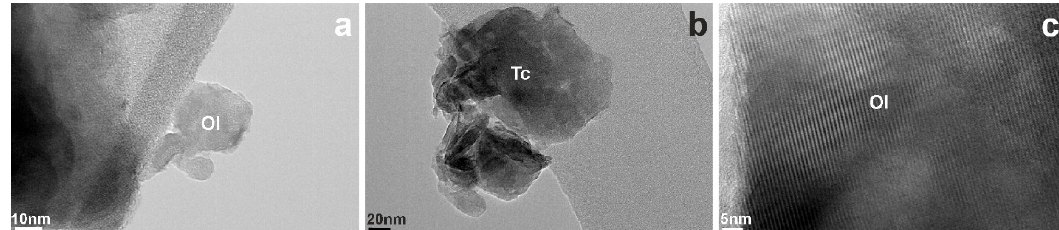
Figure 6. TEM images of the ball-milled dunite (BM46) and basalt (BM11) with the highest specific surface areas, showing: ( a ) the structural disordering of olivine in the dunite sample, as indicated by the amorphous-like contrast of the nanoparticles; ( b ) nanoparticles of talc in the basaltic sample; and ( c ) the existence of highly crystalline olivine in the basalt, as indicated by the lattice fringes (Ol: olivine, Tc: talc).